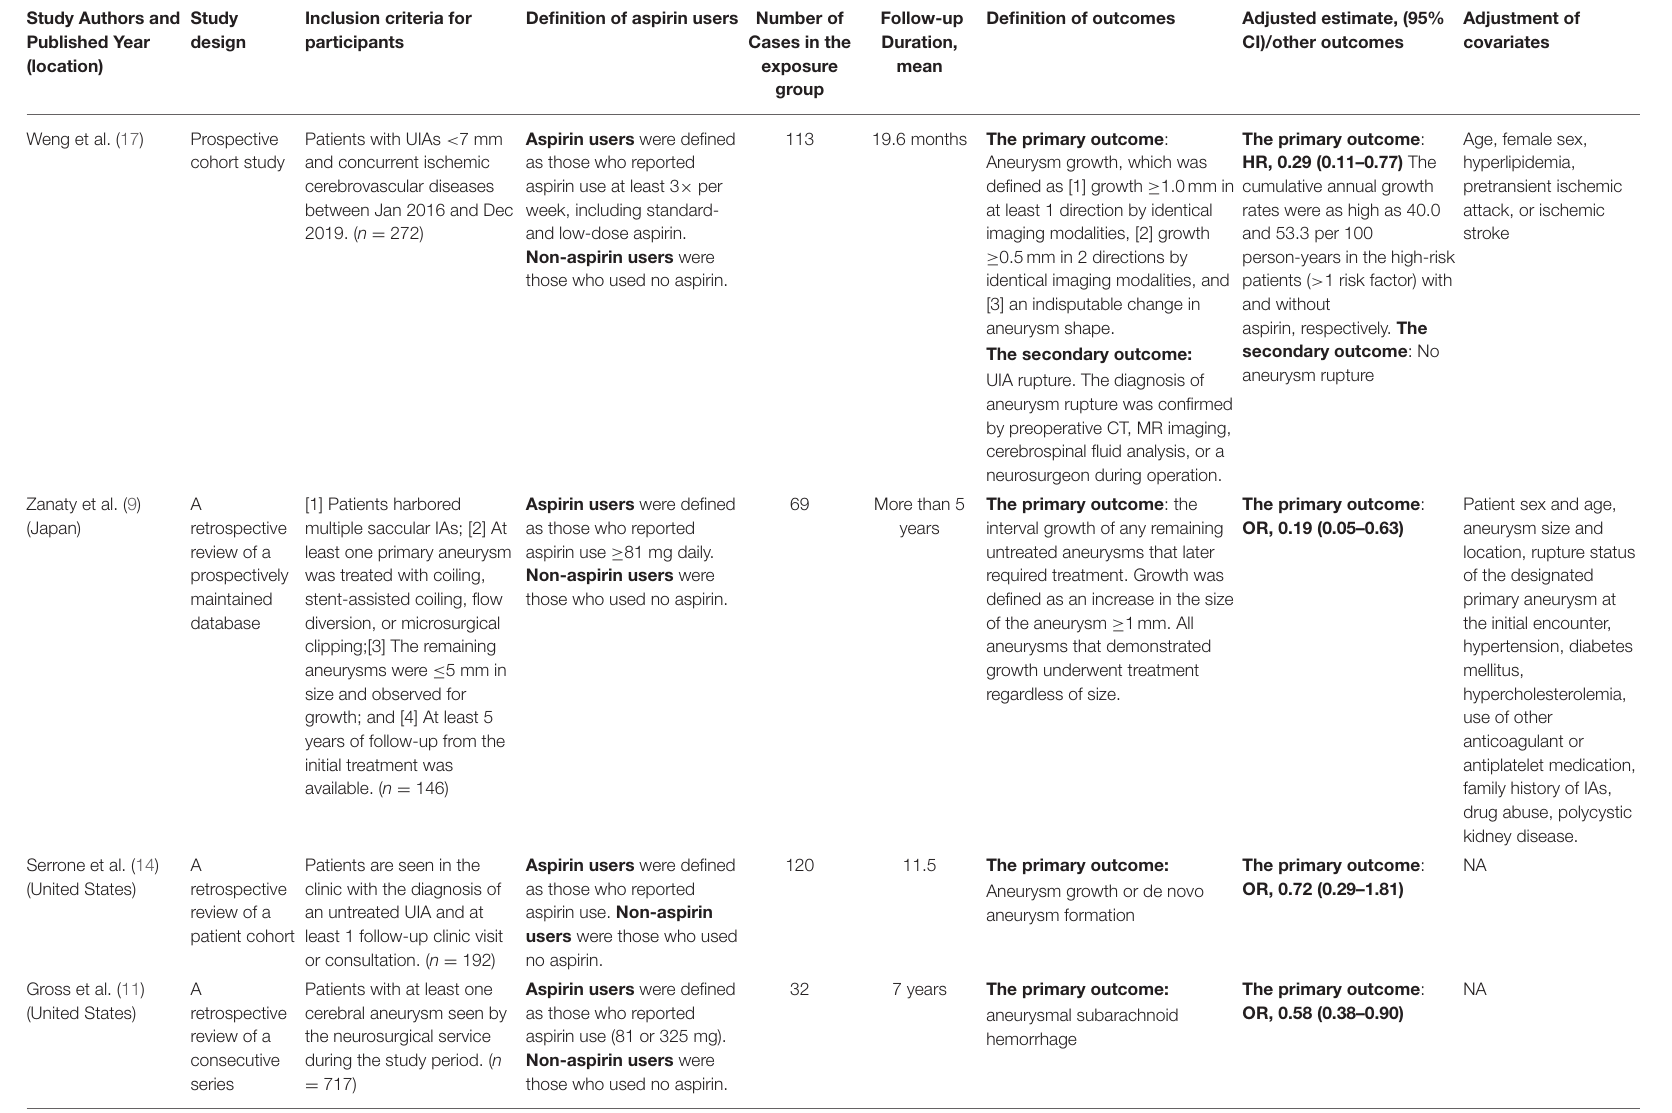
TABLE 1 | Characteristics of included studies in the systematic